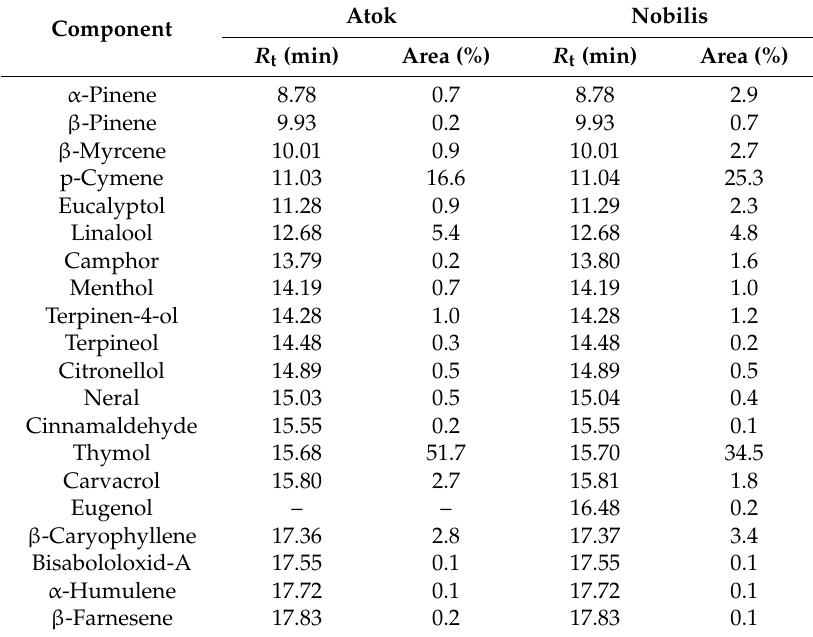
Table 2. Constituents of Atok and Nobilis thyme